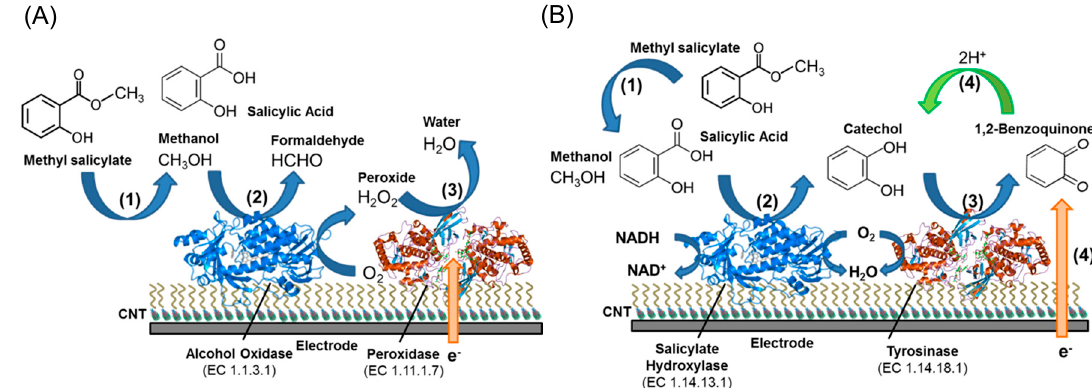
Figure 13. Schematic illustration of methyl salicylate detection using two types of bi-enzyme based carbon nanotube/PBSE modified biosensor with ( A ) Alcohol oxidase and horseradish peroxidase and ( B ) salicylate hydroxylase and tyrosinase [125,126].